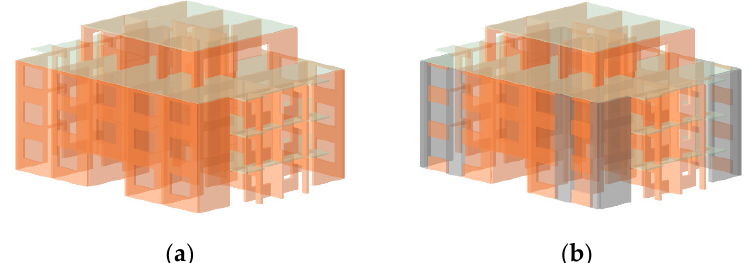
Figure 21 . Numerical models: ( a ) original structure and ( b ) retro fi tt ed structure. Figure 21. Numerical models: ( a ) original structure and ( b ) retrofitted structure. Fundamental periods for the retrofitted structure, which were obtained using three different numerical models which take into account the extent of cracking and two